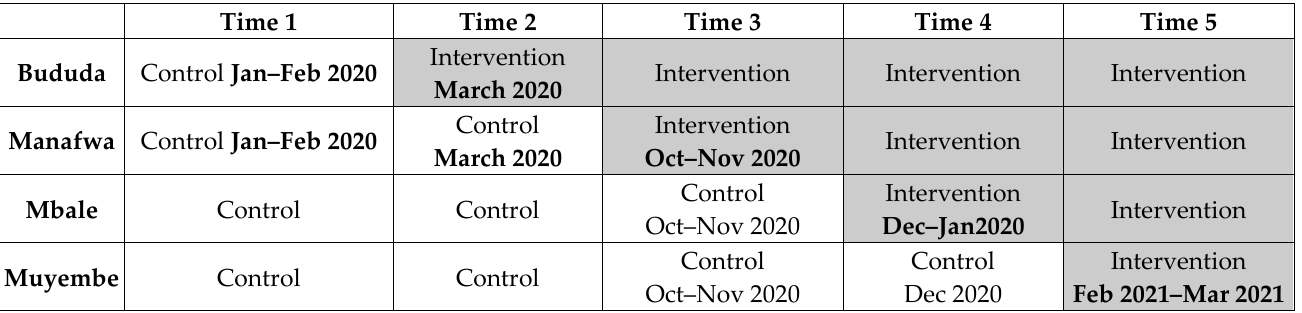
Figure 2. Trial duration and dates of study periods.